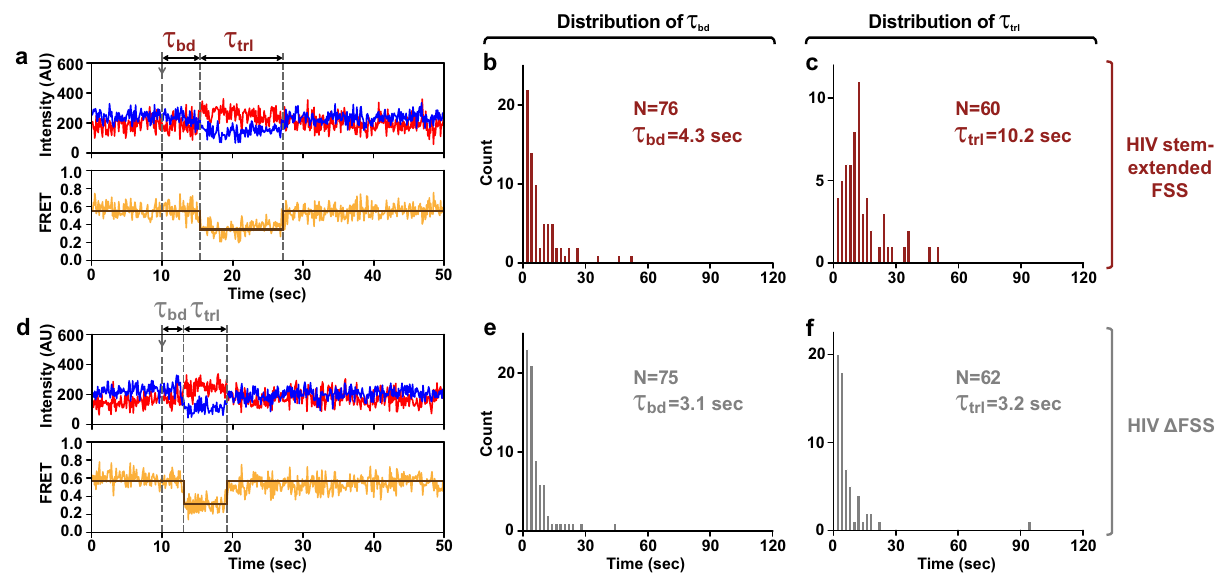
Fig. 7 The FSS-induced inhibition of translocation is alleviated by extension of the stem length. The S6-cy5/L9-cy3-labeled ribosomes containing P-site N -Ac-Met-Phe-tRNA Phe were programmed with either HIV stem-extended FSS ( a – c ) or HIV Δ FSS ( d – f ) mRNA (Fig. 1). The FSS was positioned 11 nucleotides downstream of the P-site codon. a , d Representative FRET traces show cy3 donor fl uorescence (blue), cy5 acceptor fl uorescence (red) and FRET ef fi ciency (orange) fi tted by two-state HHM (brown). Arrows mark the injection of EF-Tu (cid:129) GTP (cid:129) Tyr-tRNA Tyr and EF-G (cid:129) GTP. τ bd is the dwell time between the injection and the Tyr-tRNA Tyr binding to the ribosomal A site, which corresponds to the transition from NR (0.6 FRET) to R (0.4 FRET) state of the ribosome. τ trl is the dwell time between the A-site tRNA binding and the EF-G-catalyzed ribosome translocation, which corresponds to the transition from R to the stable (i.e. lasting over 4 s) NR state of the ribosome. b , c , e , f Histograms (2 s binning size) show the distributions and median values of τ bd and τ trl . N indicates the number of traces assembled into each histogram. The full-length views of the FRET traces are shown in Supplementary Fig. 8. Source data are provided as a Source Data fi